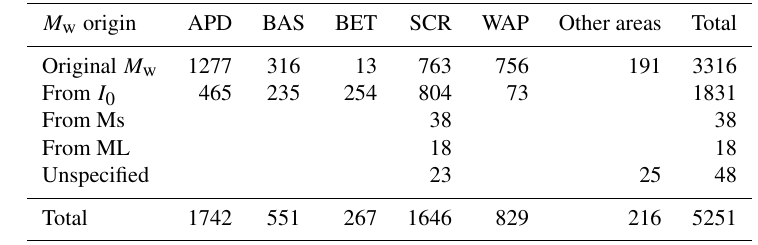
Table 4. Number of earthquakes from regional catalogues considered in EPICA according to their calibration region and the origin of EPICA magnitude. APD: Apennines, north-eastern Alps and Dinarides; BAS: broad Aegean, shallow; BET: Betics; SCR: stable continental region; WAP: Western Alps and